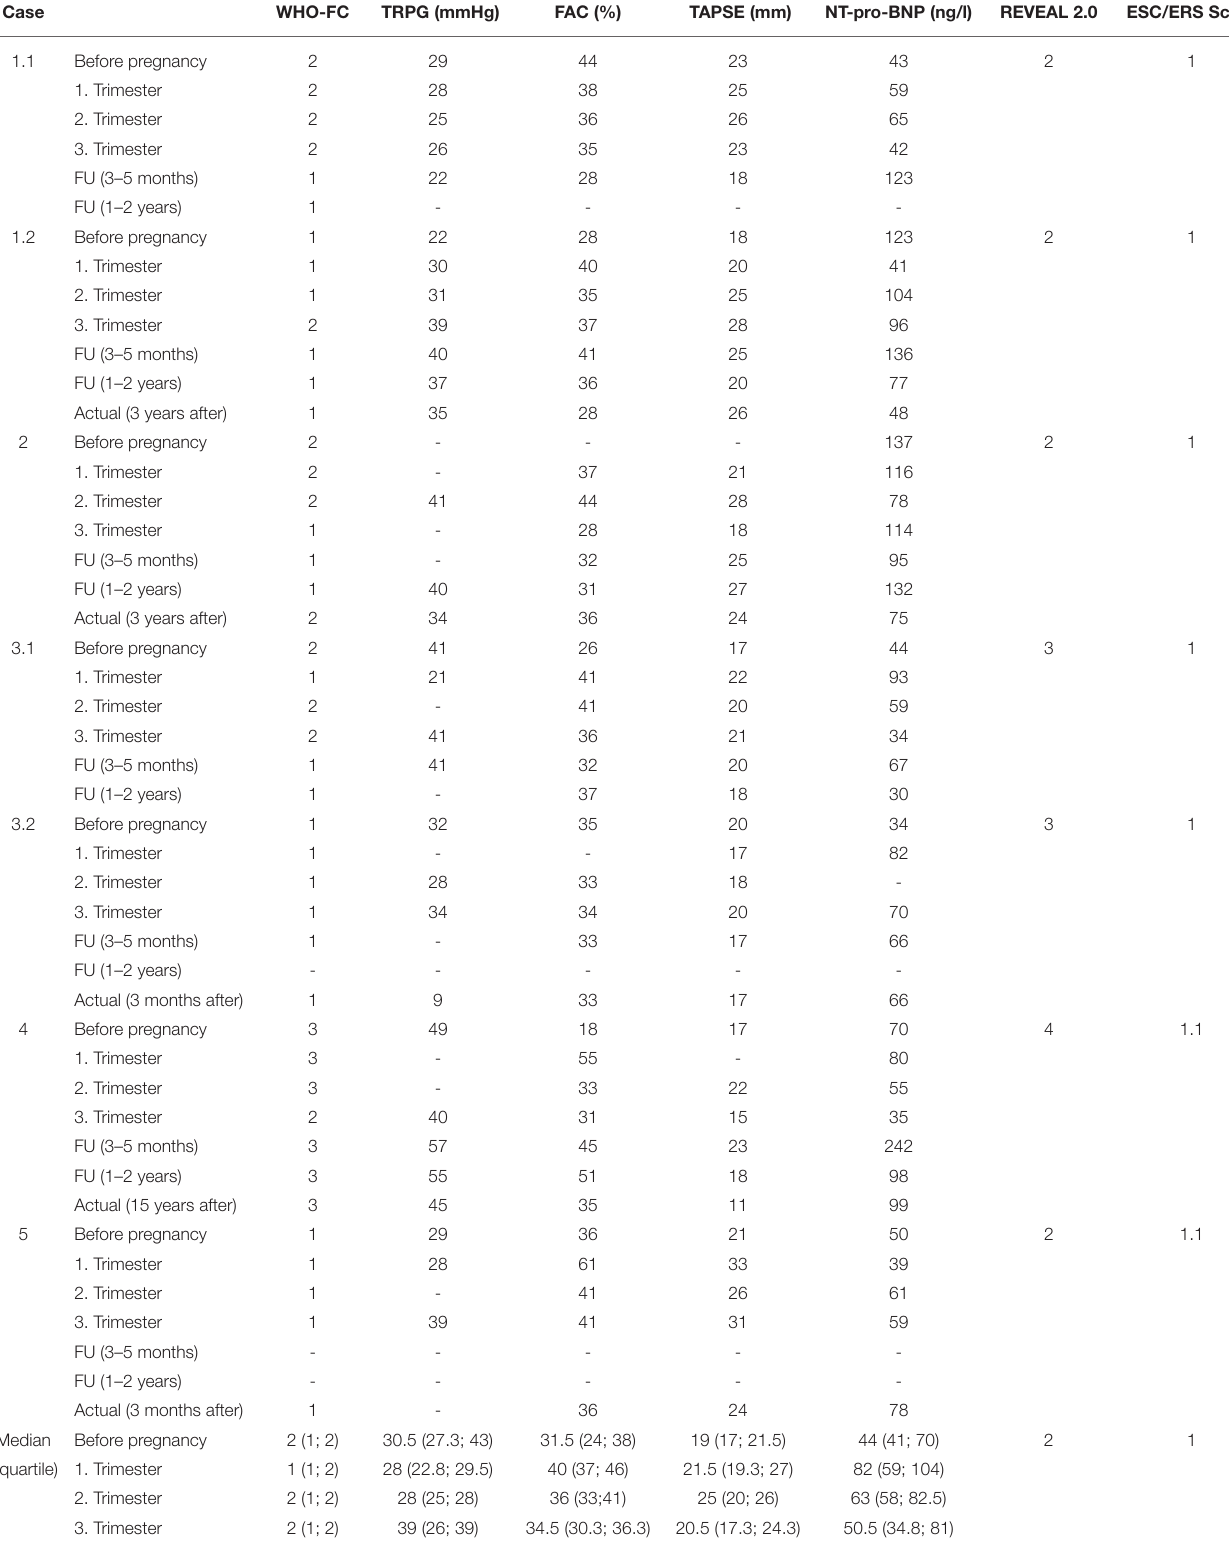
TABLE 2 | Echocardiographic, laboratory and clinical data during and after